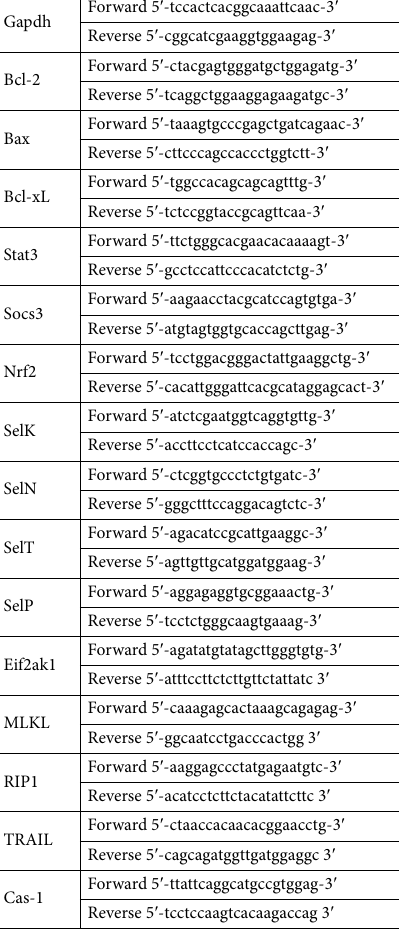
Table 1. Primer sequences for real-time polymerase chain reaction